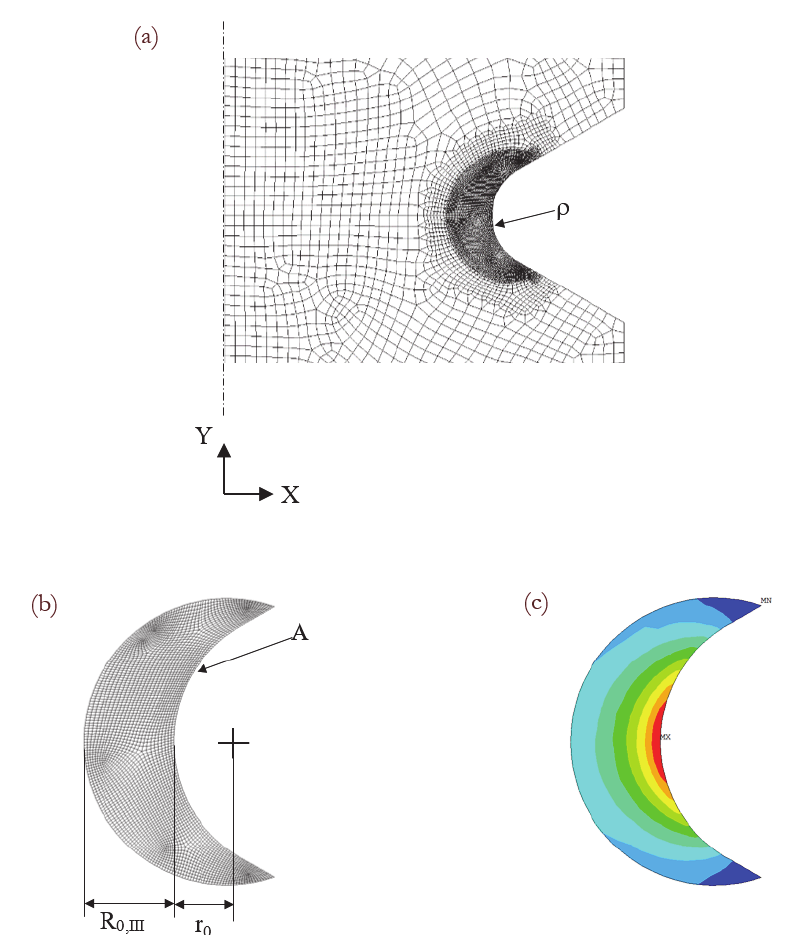
Figure 3: (a) Refined FE mesh (about 500 FE inside the control volume) adopted in the numerical analyses to evaluate the exact SED value. The Y-axis coincides with the axis of the specimen. (b) Details of the FE mesh inside the control volume and (c) SED contour lines. Considered case: NB specimen made of SGV 410 steel, with  = 1.07 mm, R 0,III = 0.716 mm, r 0 = 0.428